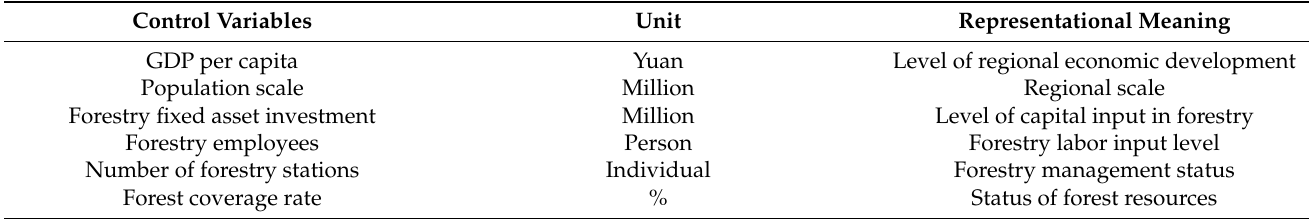
Table 2. Table of control